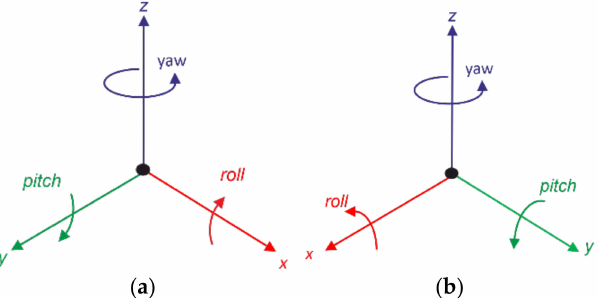
Figure 5. Diagram the location of three rotation angles around the RPY axes, related to the Inertial Measurement Unit (IMU). Left-handed system ( a ), right-handed system ( b ). Own study based on